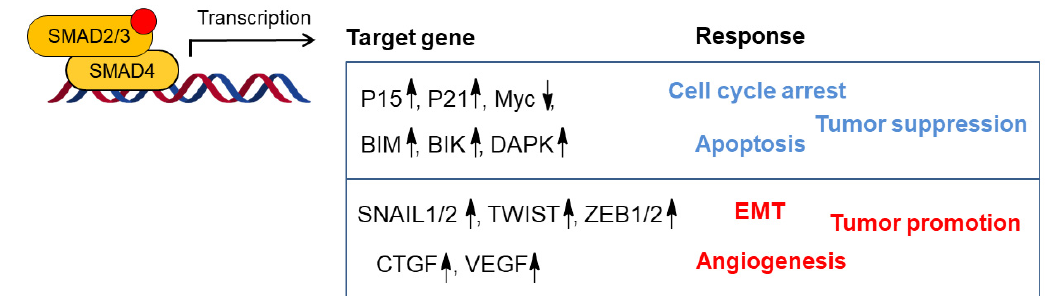
Figure 2. Biphasic role of TGF- β / SMAD signaling in cancer progression. TGF- β has a dual function in cancer as a tumor suppressor processes (in blue) and a tumor promoter processes (in red). In normal cells and early stage cancer cells, TGF- β acts as tumor suppressor by inducing cell cycle arrest and apoptosis. However, in late-stage cancer, increased TGF- β signaling can promote cancer progression including epithelial-to-mesenchymal transition (EMT) and angiogenesis. Cellular responses to TGF- β signaling are mediated via SMAD2 / 3-SMAD4-dependent regulation of specific target genes.